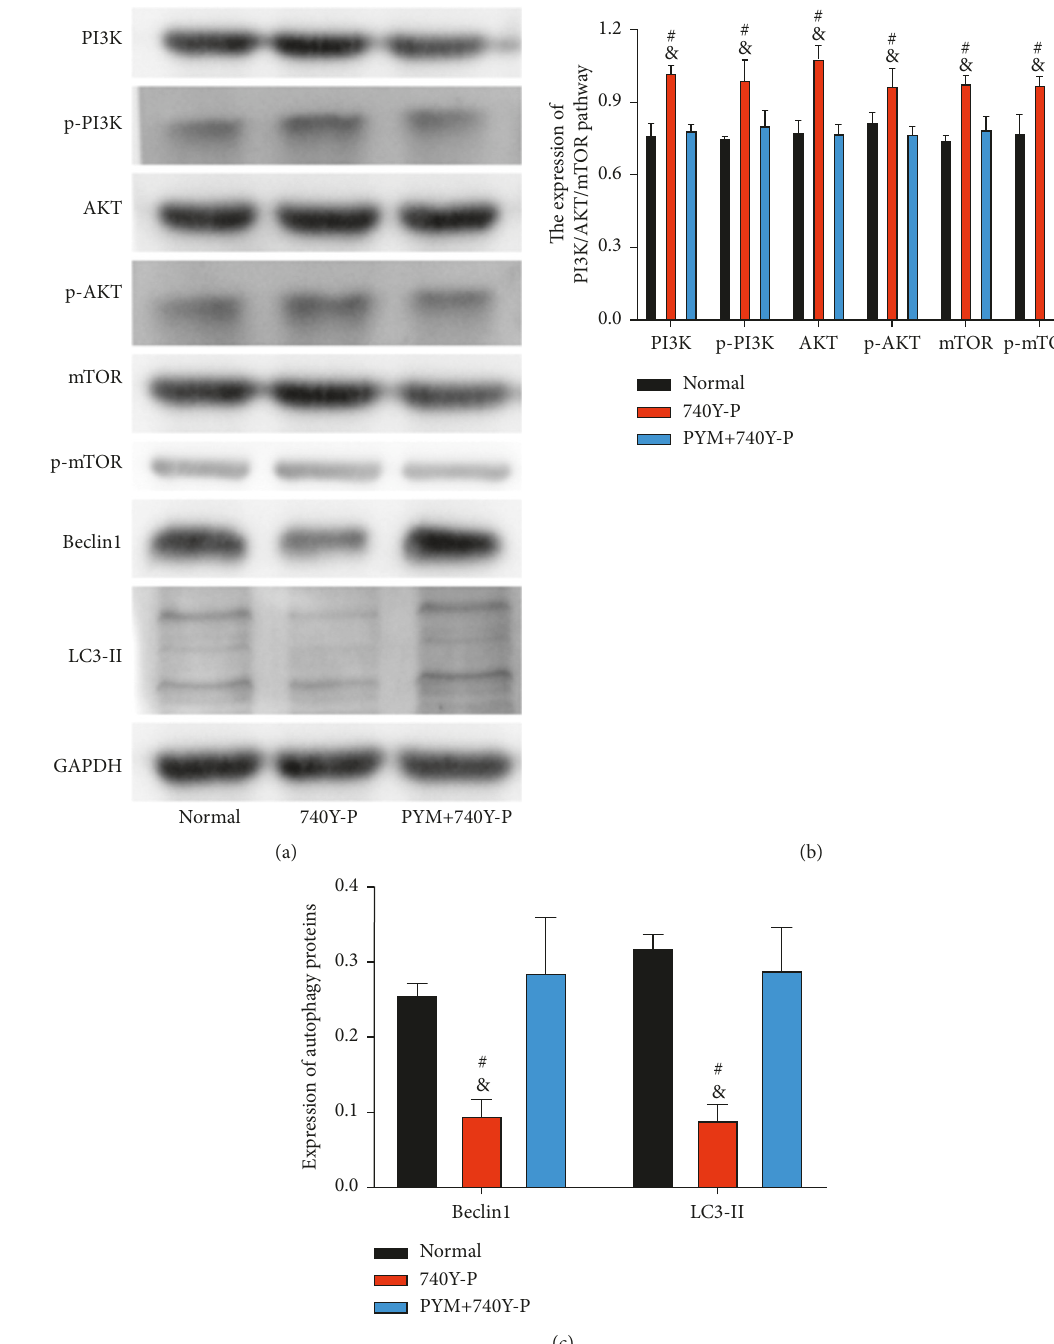
Figure 4: PYM influences OC autophagy via PI3K/AKT/mTOR axis. (a) WB map. (b) PI3K/AKT/mTOR pathway protein expression. (c) Autophagy protein expression. Compared with the normal group, # P